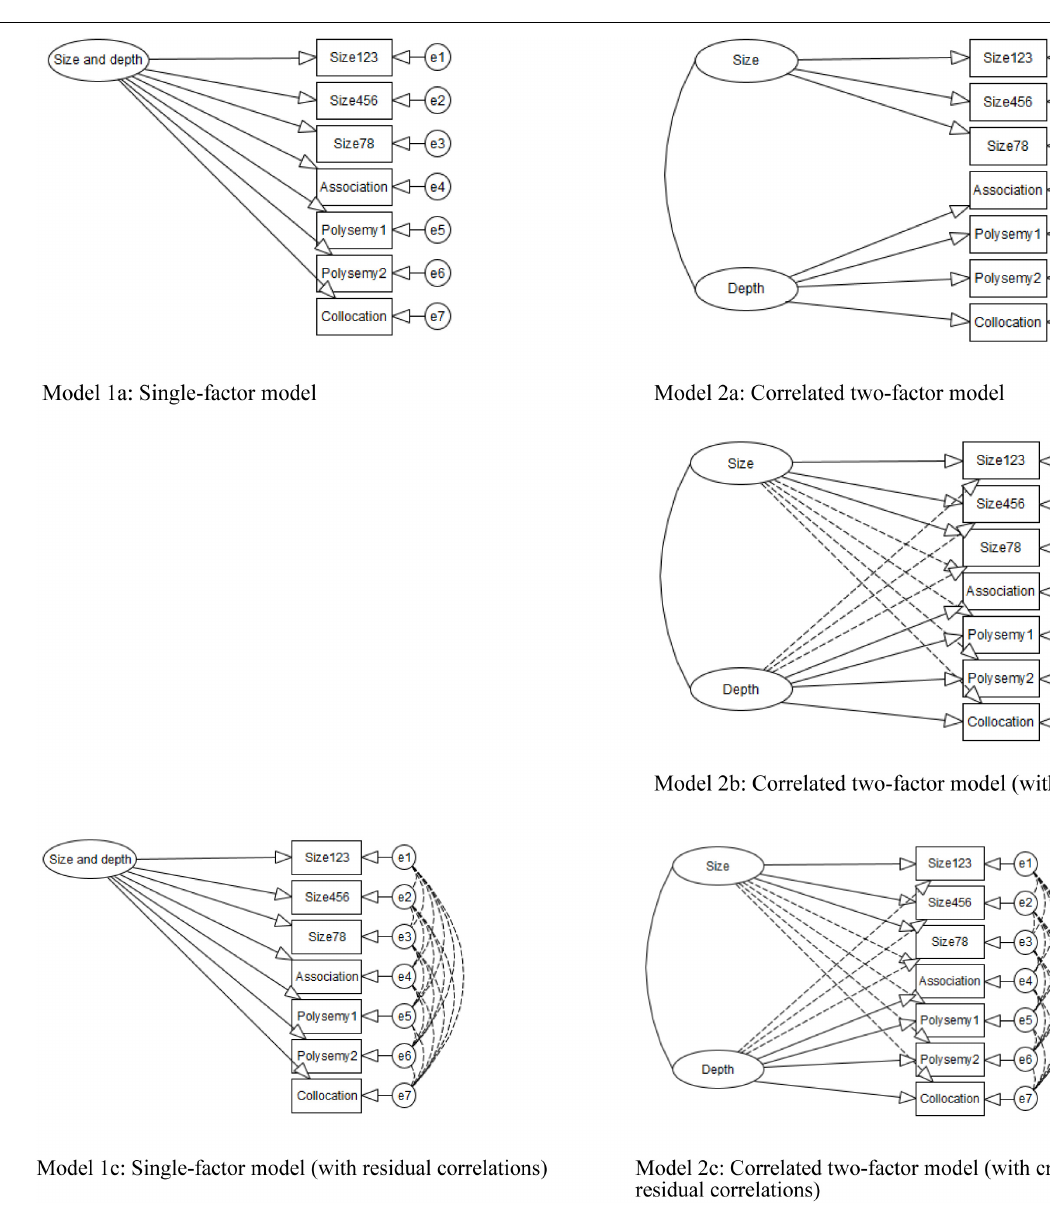
FIGURE 2 | Models of vocabulary size and depth using Bayesian SEM. Undotted line = major loading; dotted line = minor loading. All residuals are correlated in Models 1c and